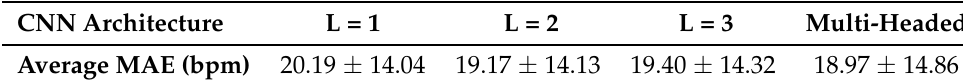
Table 4. Results for different CNN